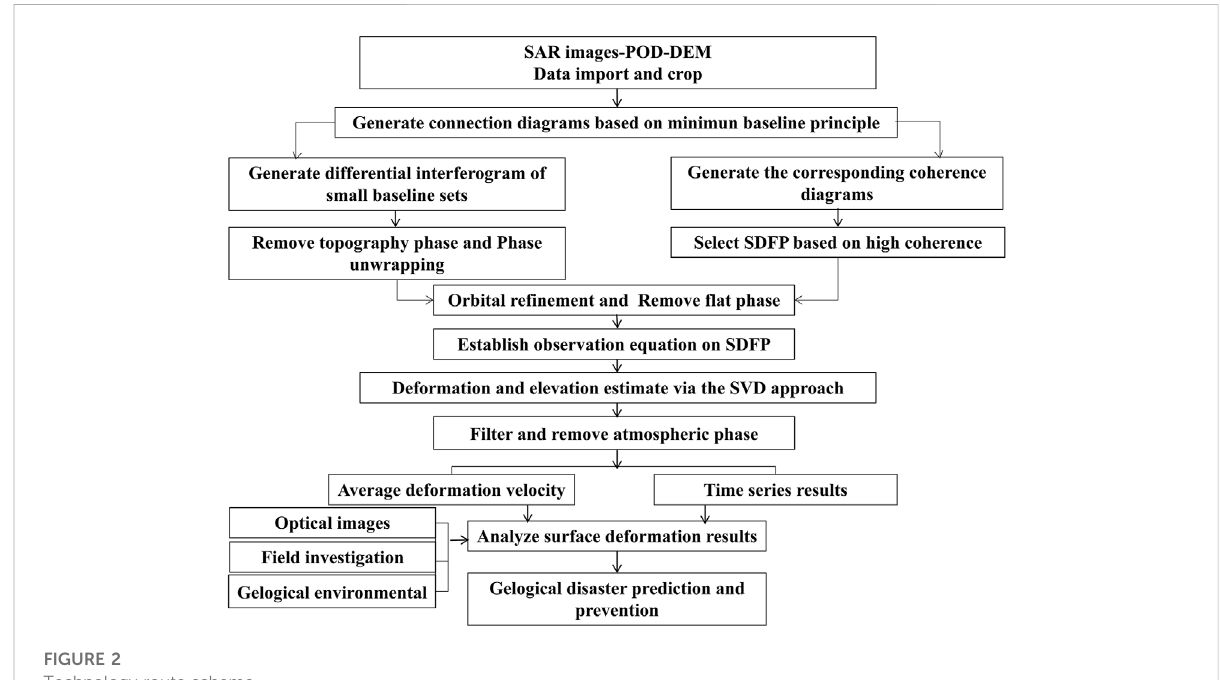
FIGURE 2 Technology route scheme.